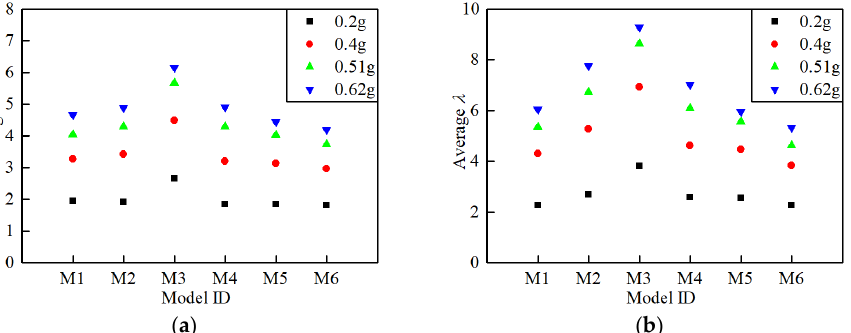
Figure 16. The average λ of columns along the slope direction on the 1st floor: ( a ) Axis 1; ( b ) Axis 2.